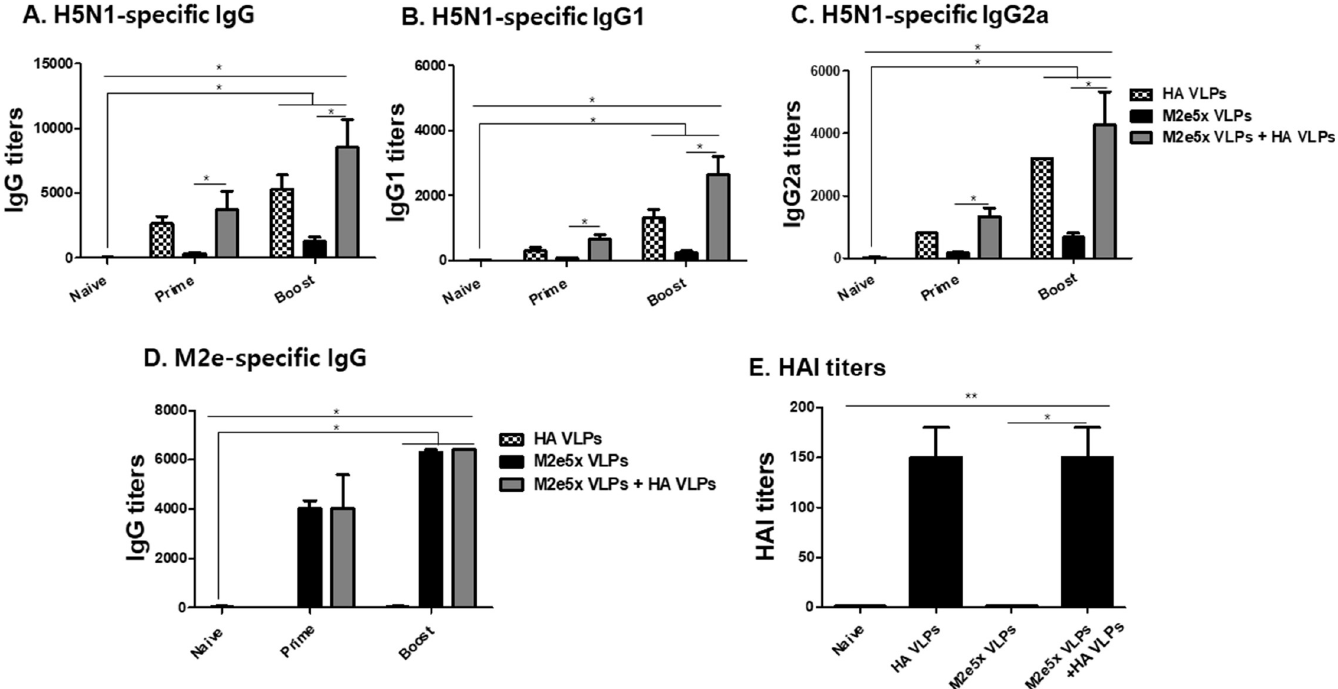
Fig 2. Antibody response in sera. Mouse sera collected from immunized mice were used to determined antibody responses. H5N1—specific IgG, IgG1 and IgG2a antibody responses and M2e - specific IgG antibody responses were determined. Significantly higher levels of influenza virus—specific IgG (A, � P < 0.05), IgG1 (B, � P < 0.05) and IgG2a (C, � P < 0.05) antibody responses after boost were found compared to prime and na ï ve. Higher levels of IgG and IgG2a antibody responses were found compared to IgG1 in combinatorial VLPs group compared to M2e5x VLPs. Similar levels of M2e - specific IgG antibody responses (D, � P < 0.05) were found in M2e5x VLPs and combinatorial groups. Higher levels of HAI titers against rH5N1 virus in sera were found in combinatorial and HA VLPs groups ( �� P < 0.05). Data are expressed as mean ± SD.